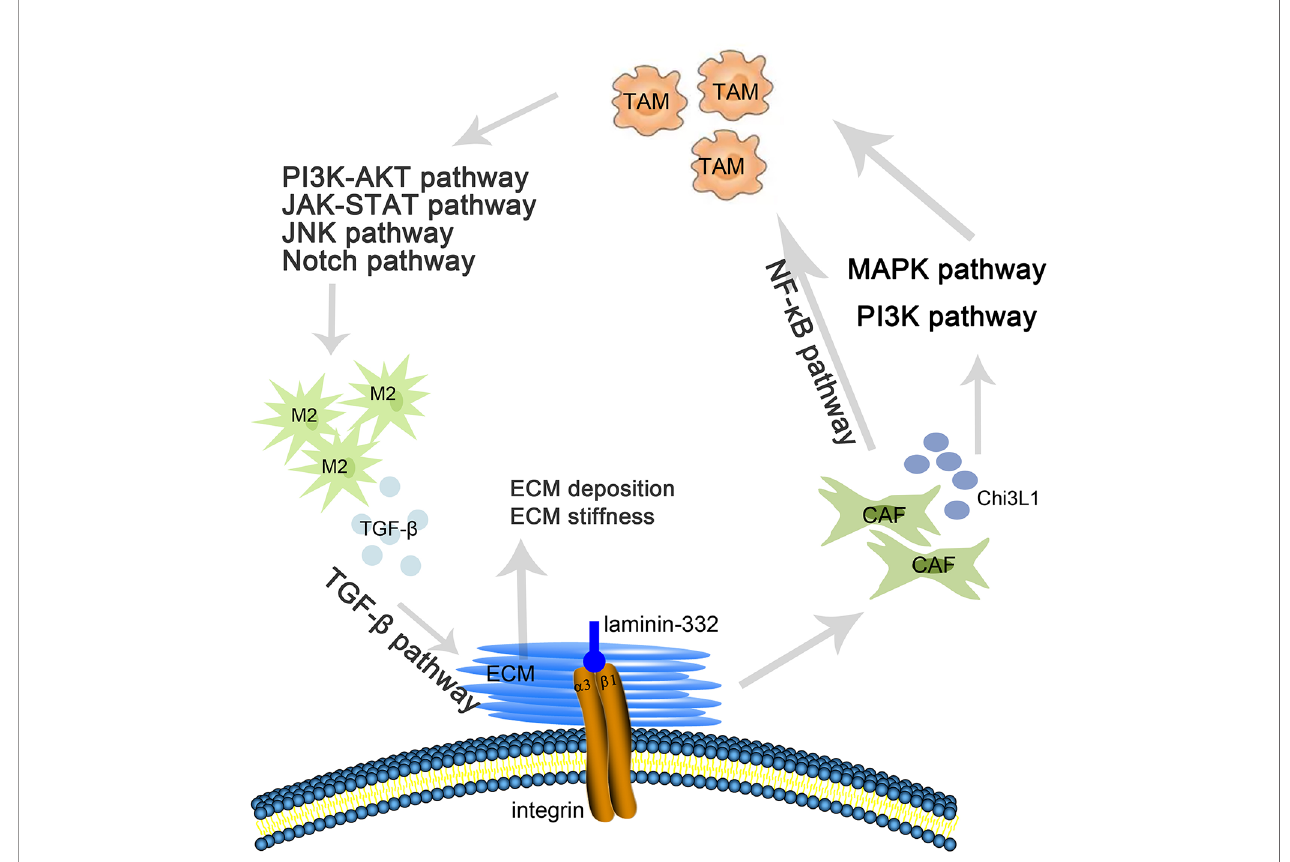
FIGURE 9 | The role of ITGA3 in regulating ECM and TIL in fi